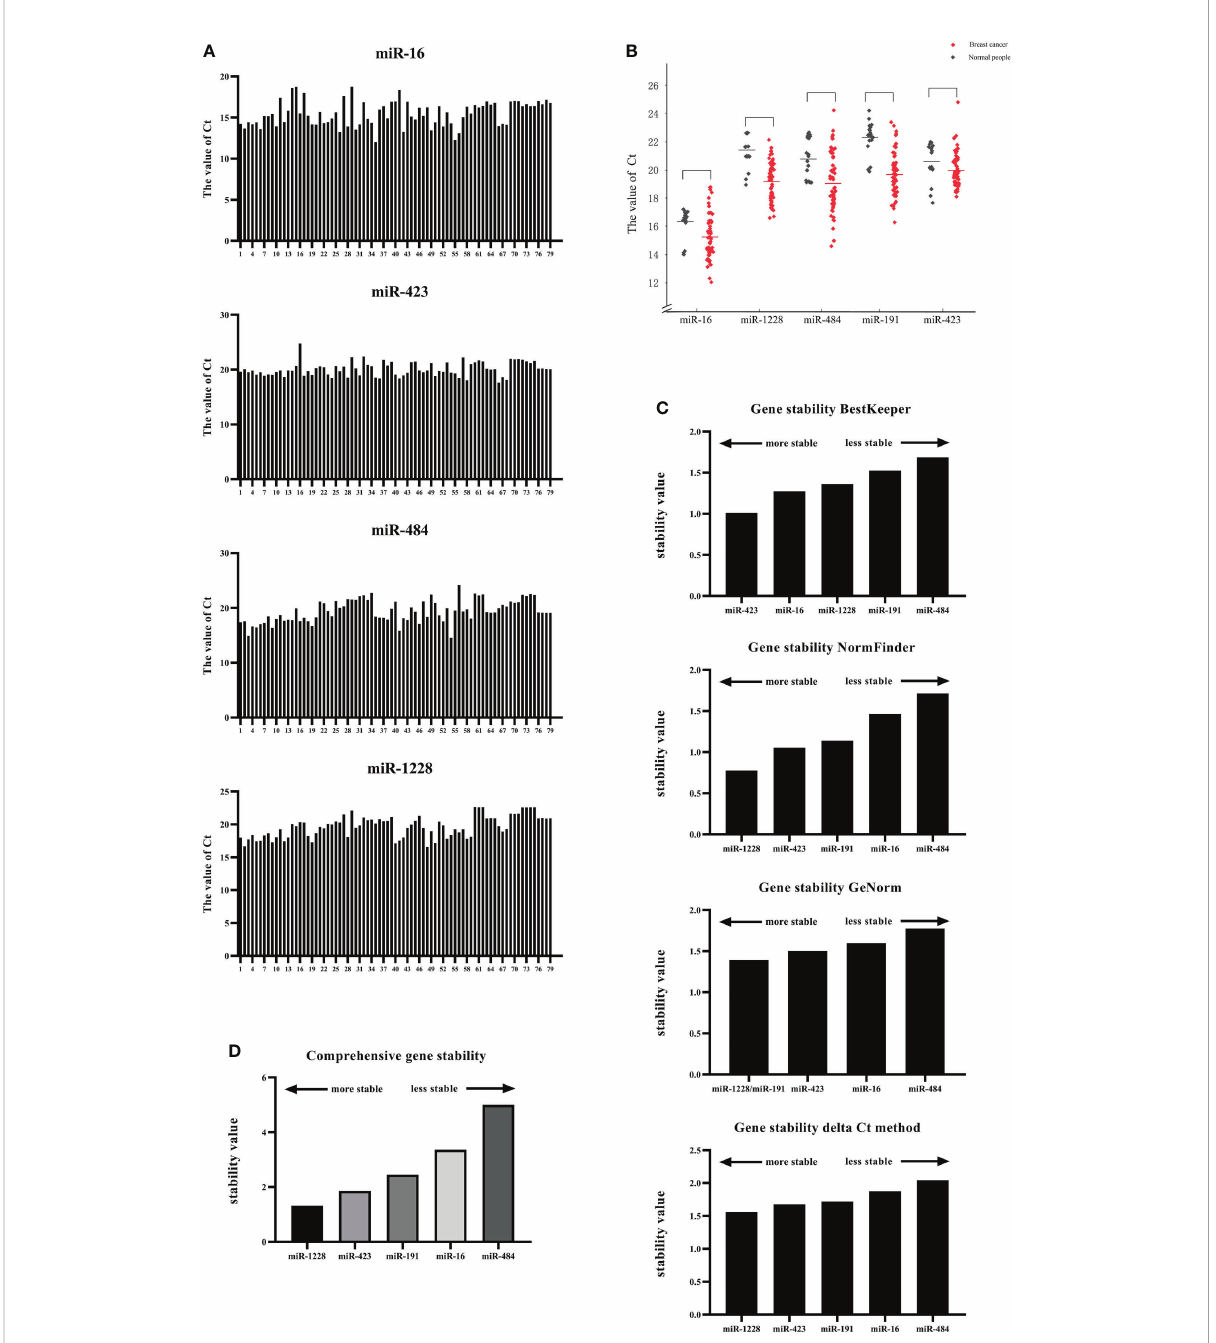
FIGURE 3 Screening of candidate reference genes and analysis of their applicability. (A) Expression of candidate internal reference genes in serum exosomes under breast cancer and healthy conditions. (B) The expression levels of miR-16, miR-1228, miR-484, miR-191, and miR-423 in the serum exosomes of breast cancer patients and normal human serum exosomes were compared. (C) The stability of the fi ve candidate internal genes was analyzed and sorted using four algorithms, namely, GeNorm, NormFinder, BestKeeper, and D CT. (D) The stability of the fi ve candidate internal genes was analyzed and sorted using